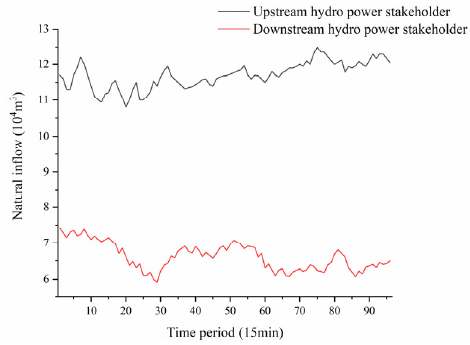
Figure A2. Prediction intervals of solar power stakeholder.